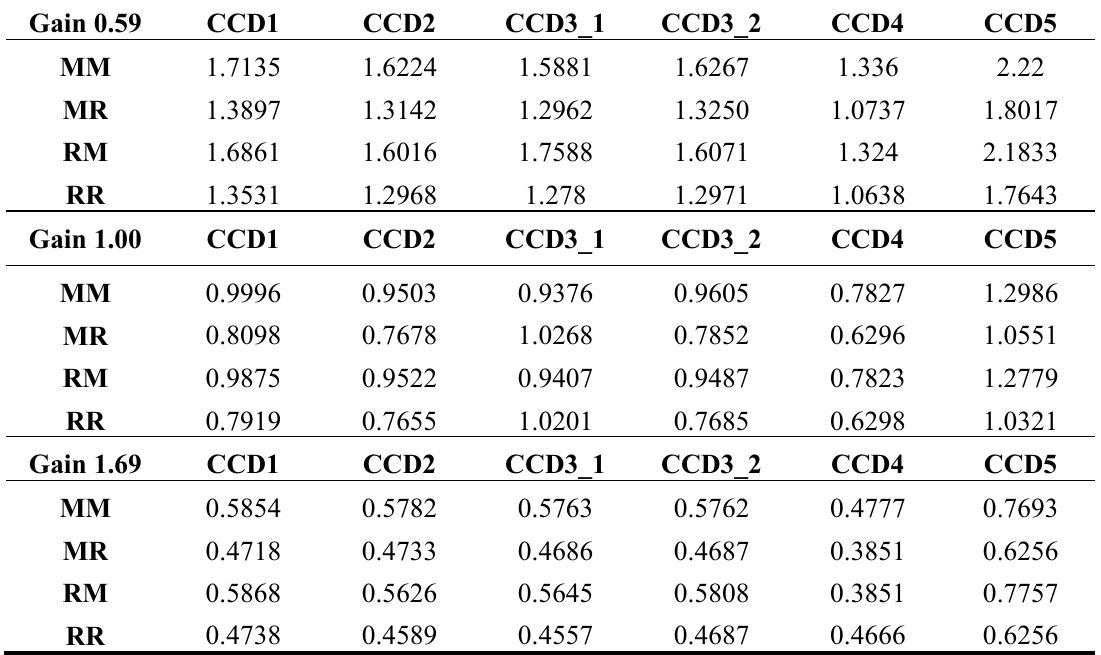
Table 2. Absolute calibration coefficients for all possible equipment combinations, gains, transmission channels and spectral